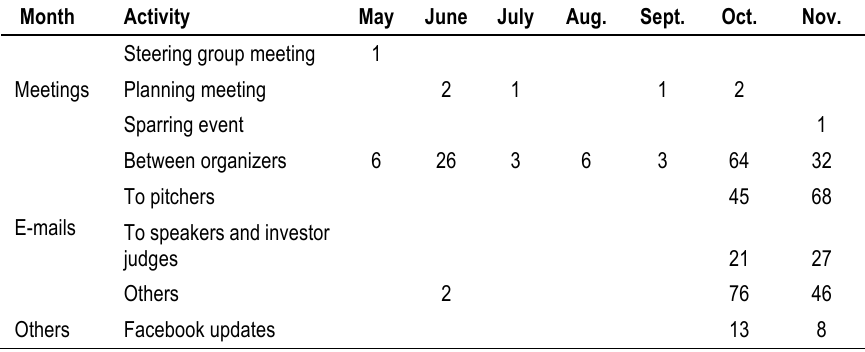
Table 1. Project communication activities during the planning period for the HWB pitch